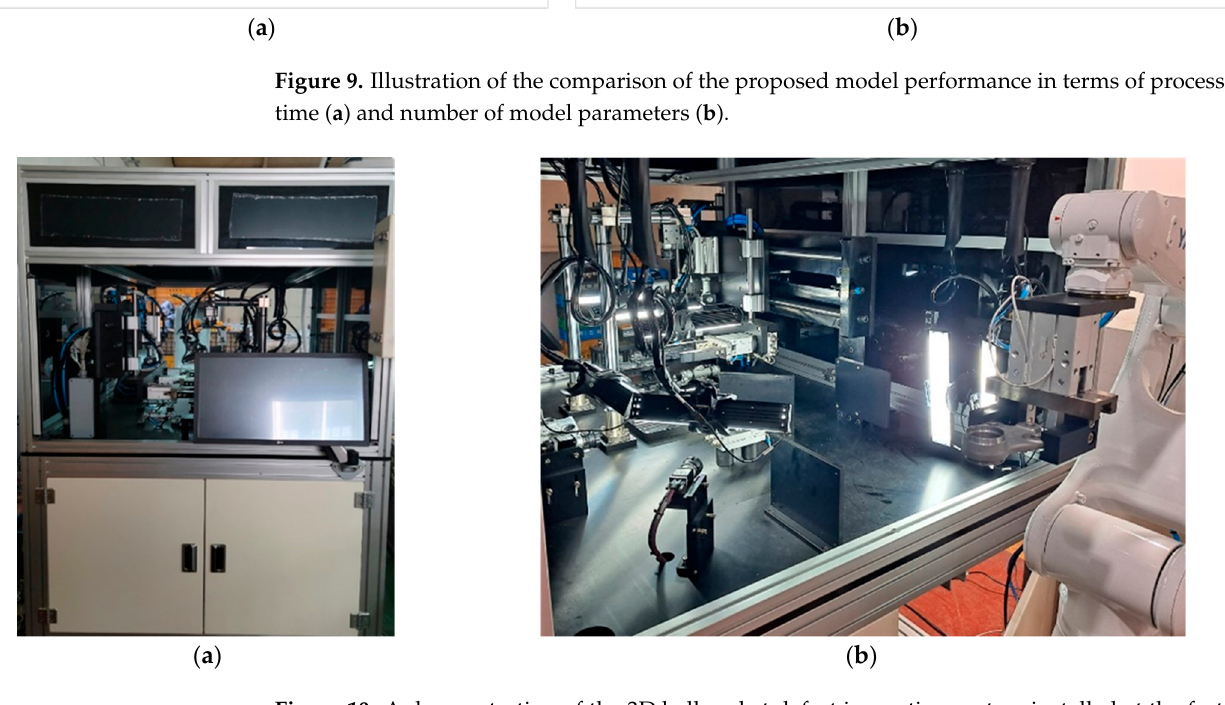
Figure 10. A demonstration of the 3D ball socket defect inspection system installed at the factory. ( a ) Outside view of the inspection system, ( b ) inside view of the inspection